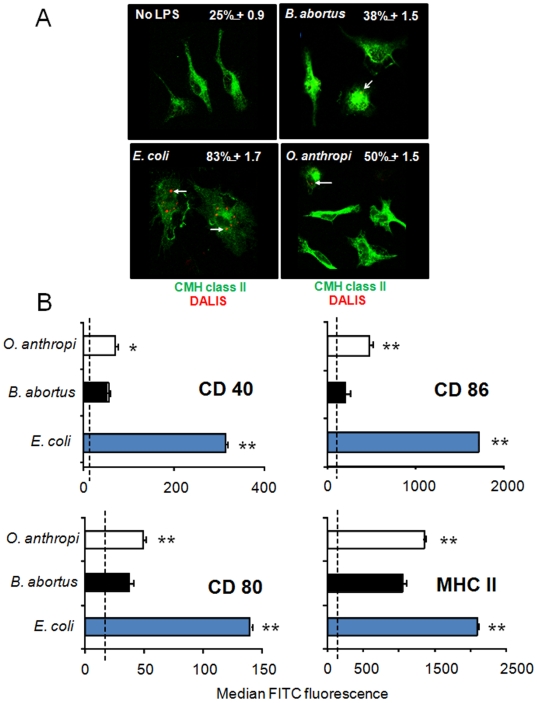

OaLPS induces dendritic cell maturation that lay between BaLPS. and SeLPS.(A) BMDC were incubated with 0.1 µg of EcLPS, 10 µg of BaLPS or 10 µg of OaLPS in 1 ml culture and labeled with the anti-FK2 antibody for detection of DALIS at 24 h. The percentage of BMDC positive for DALIS is indicated. (B) BMDC incubated as in “A” were labeled with fluorescent anti-CD40, CD-80, CD-86 and MHC II. Values of median fluorescence correspond to four independent experiments. Values of p< 0.05 (*) and p<0.005 (**) with respect to BaLPS are indicated.